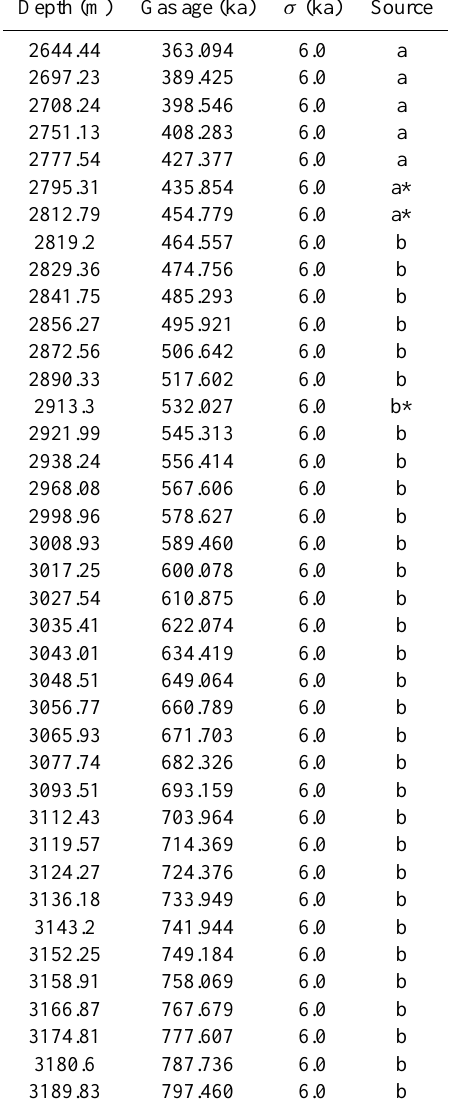
Table 1. Orbital ages from δ 18 O atm for EDC.